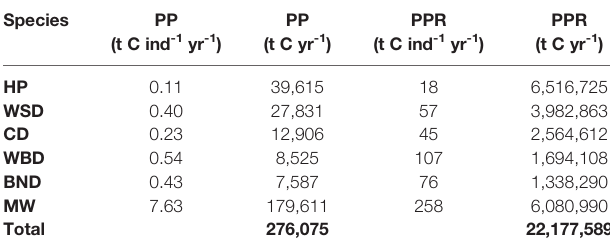
TABLE 6 | Cetacean driven primary productivity and primary productivity requirements. Species